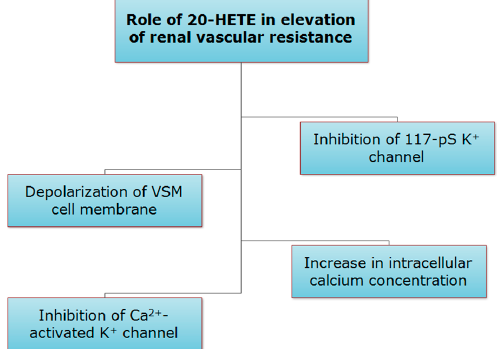
Figure 4. Role of 20-HETE in elevation of renal vascular resistance. 191